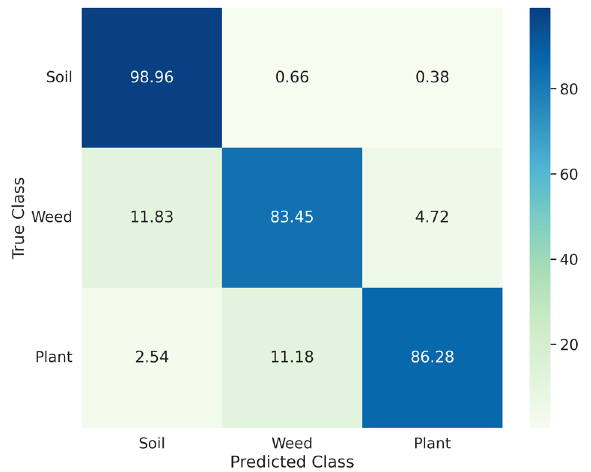
Figure 6 . Normalized confusion matrix of the U-Net++ model.